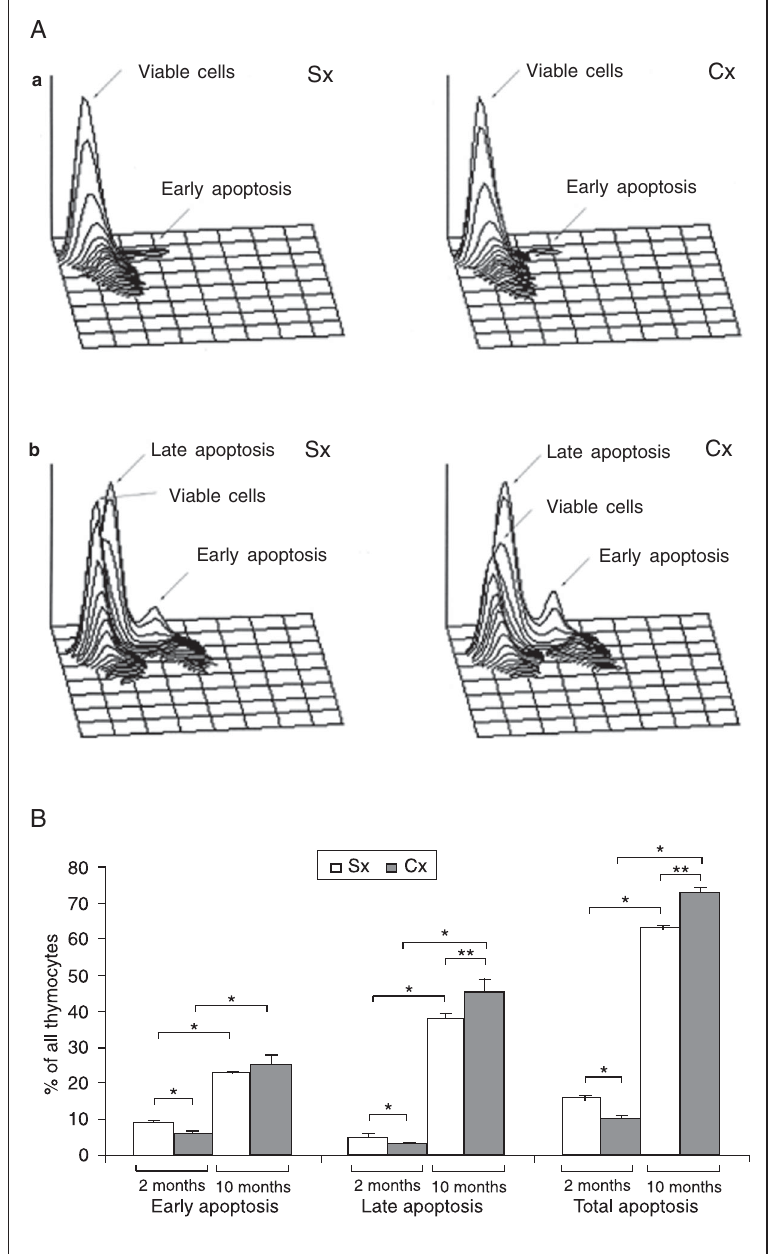
Figure 5. Effects of orchidectomy at the age of 30 days on the frequency of apoptotic cells in 18-h thymocyte cultures. The apoptotic cells were identified by MC540 binding. A , Three- dimensional plots of MC540-labeled thymocytes in cultures from (a) 2-month-old and (b) 10-month-old orchidectomized (Cx) and control rats (Sx). According to the intensity of MC540 thymocyte staining and forward scatter, two subsets of cells at distinct phases of apoptosis (early apoptosis and advanced/late apoptosis) were delineated. B , The histo- gram represents the overall percentage of apoptotic cells and the percentages of cells in early and advanced/late apoptosis in thymocyte cultures from Cx and Sx rats. Data are reported as means ± SEM for N = 5. *P < 0.05 and **P < 0.01